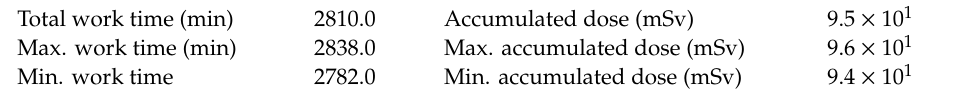
Table 13. Work time and estimated dose for the segmentation of the lower part.